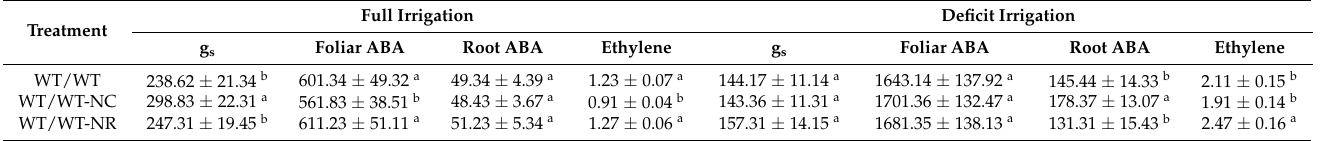
Table 4. Abaxial stomatal conductance (mmol m − 2 s − 1 ), ABA content (ng g − 1 DW), and